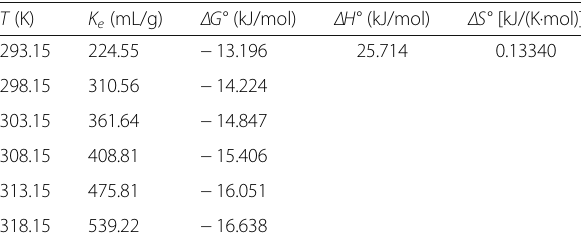
Table 4 Thermodynamic parameters for the adsorption of Cd 2+